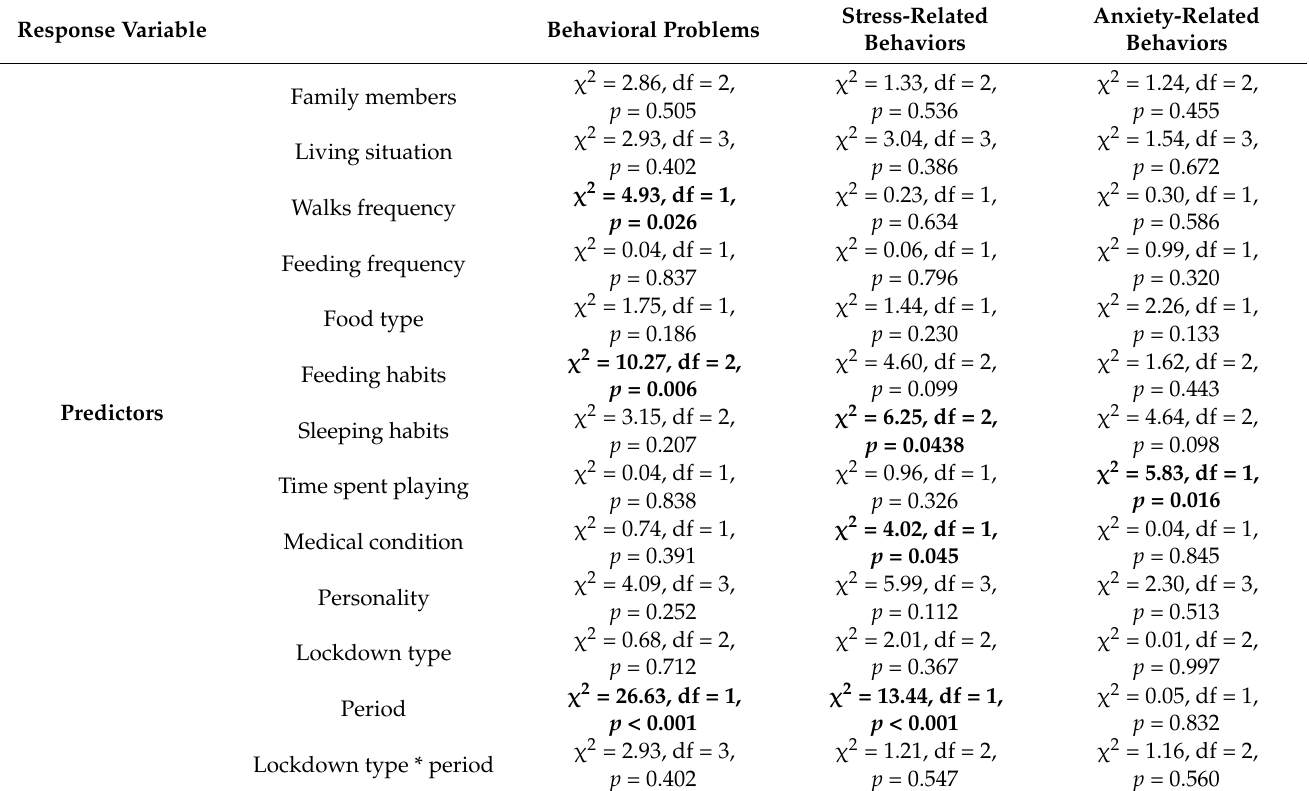
Table 3. Statistical outputs from linear mixed-effects models (LMMs) for dogs. Significant results ( p < 0.05) are bold.